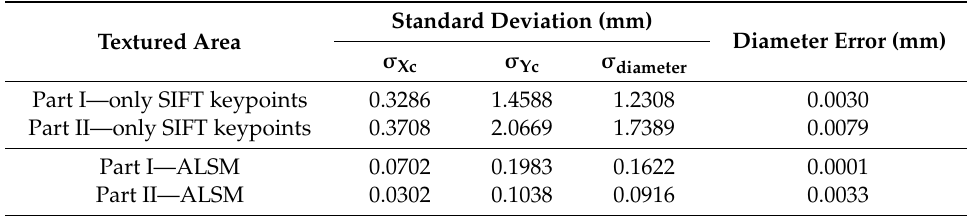
Table 5. Circle parameters estimated for the two textured